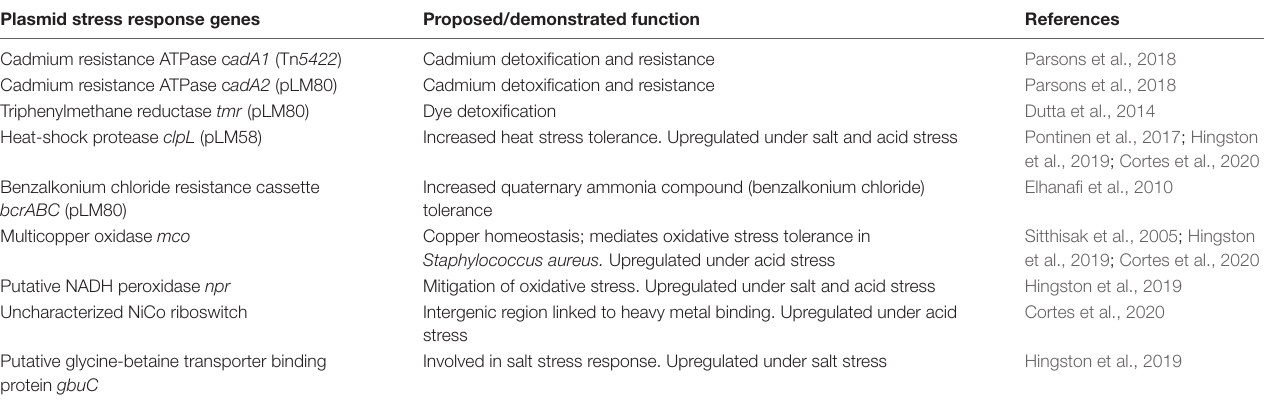
TABLE 1 | Selected plasmid-encoded genes of interest involved in stress response.